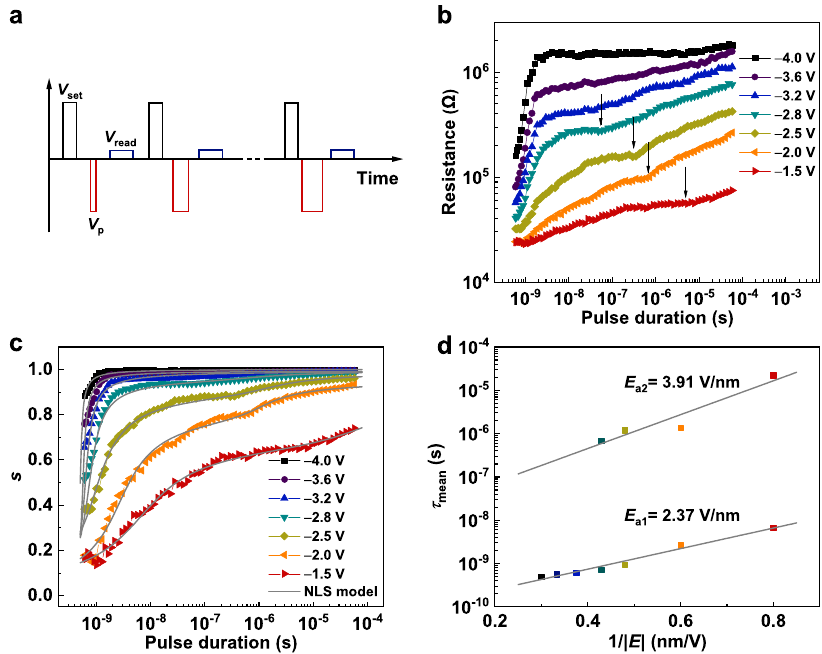
Fig. 3 Ferroelectric domain switching dynamics for the (111)-oriented PZT in FTJs. a Schematic illustration of the applied voltage pulse sequence. b Resistance measured at 0.05 V versus pulse duration. The kinks are denoted by arrows. c Relative area fraction of the ferroelectric poled-up domain versus pulse duration. The solid curves are the results of fi tting by the nucleation-limited-switching (NLS) model. d Evolution of the mean switching time ( τ mean ) as a function of the inverse of electric fi eld (1/| E |). The solid lines are the fi tting results by Merz ’ s